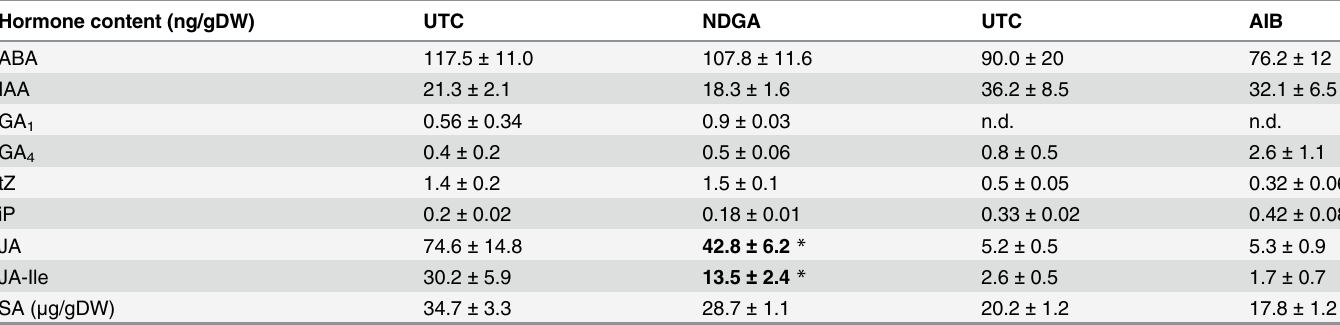
Table 4. Plant hormone contents in NDGA and AIB treated rice.